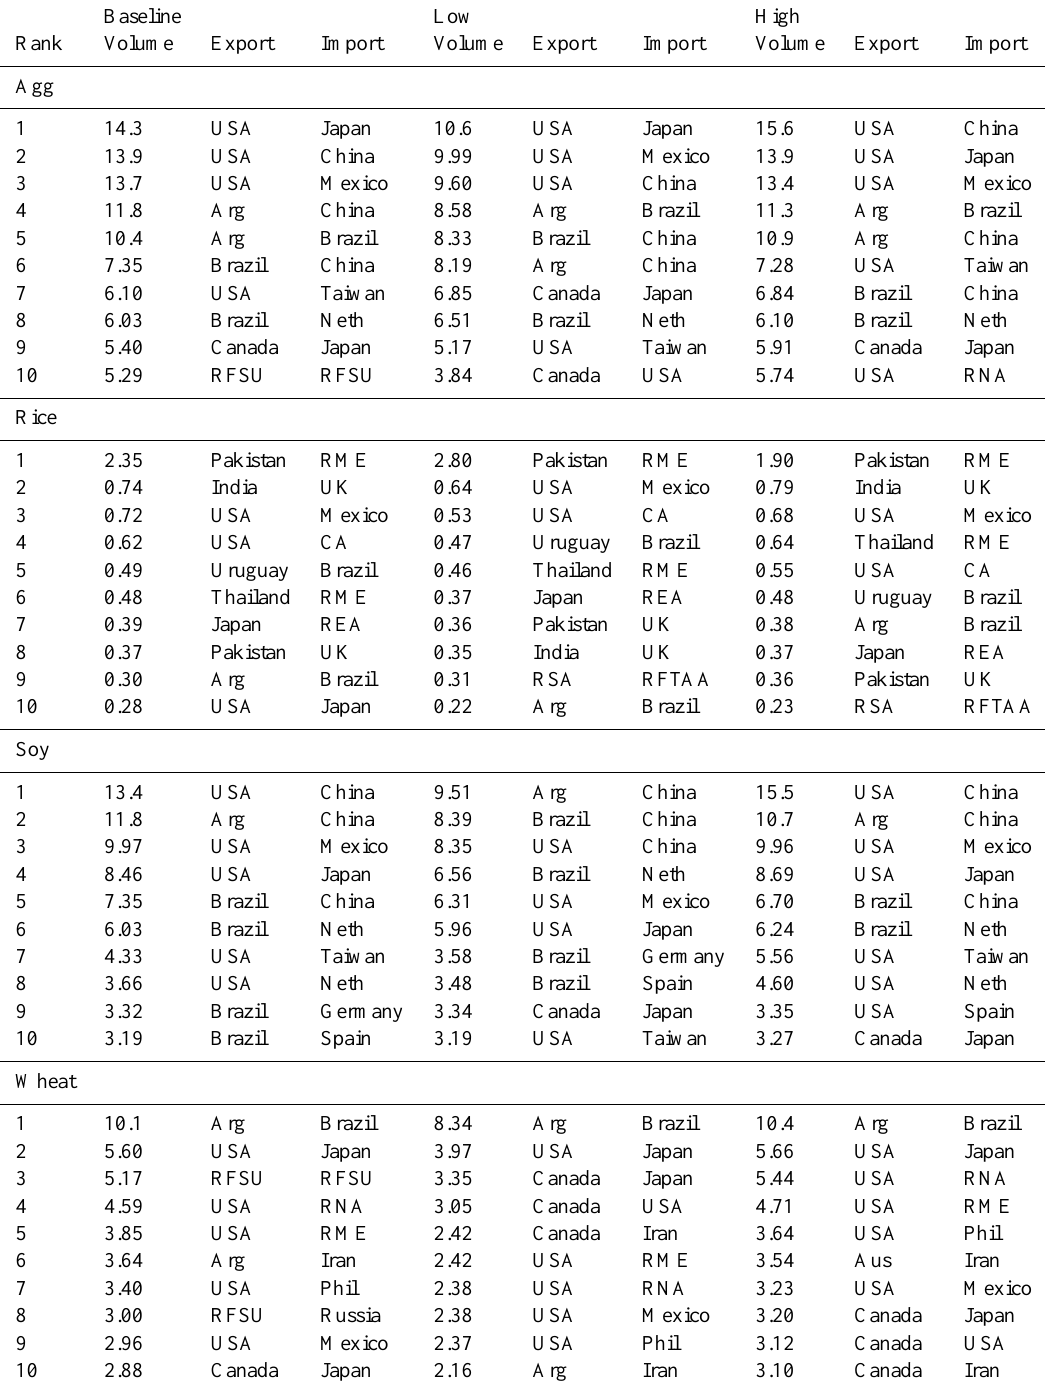
Table 3. Largest links by volume of virtual water traded by crop under the baseline, low-, and high-yield scenarios. All values are in billions of cubic meters. Note that Export refers to the country of export and Import refers to the country of import. Note that Arg indicates Argentina, Neth indicates Netherlands, Phil indicates Philippines, and Aus indicates